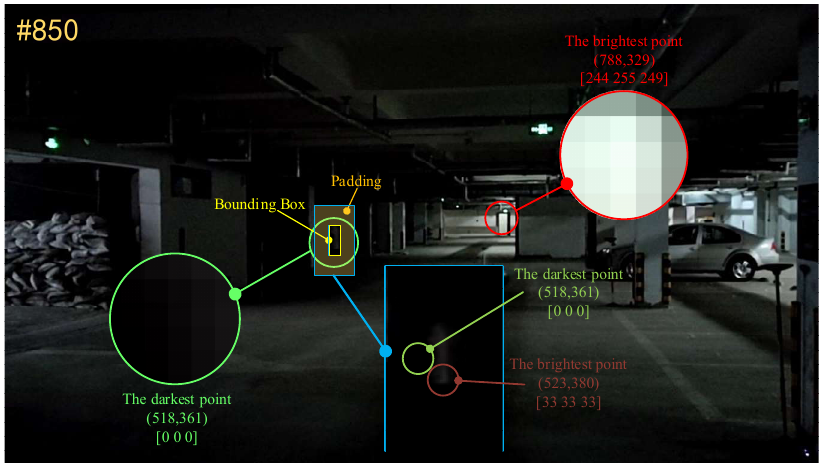
Figure 3. Selection of the low-illumination detection area. In the full view (1280 × 720), the darkest pixel (green circle) is close to the target, but the brightest (red circle) is not. The maximum RGB values close to the target are [33 33 33]. The global brightness of the image is 128, but the brightness close to the target is only 16.5.